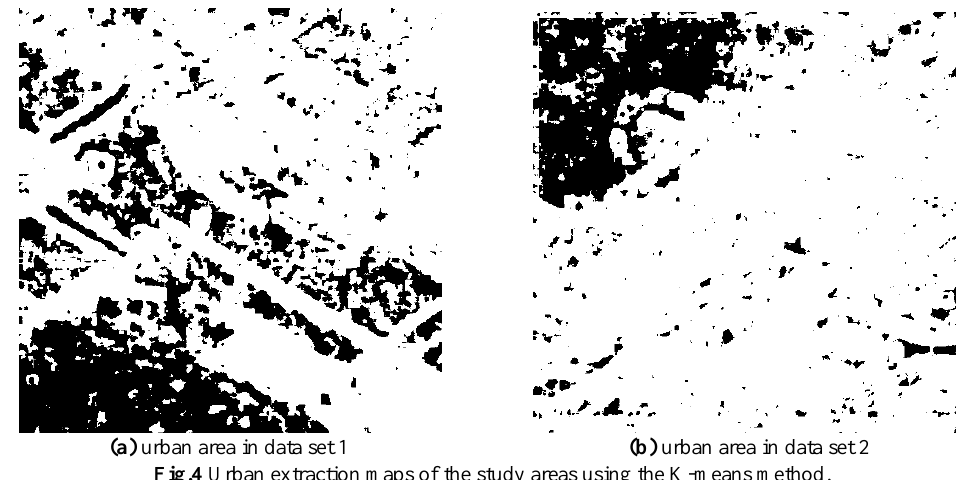
Fig.4 Urban extraction maps of the study areas using the K-means